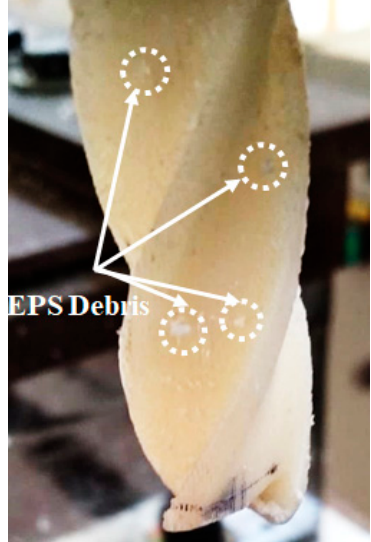
Figure 7. Pictorial view of the deposition of EPS debris on 3D printed ABS tool.